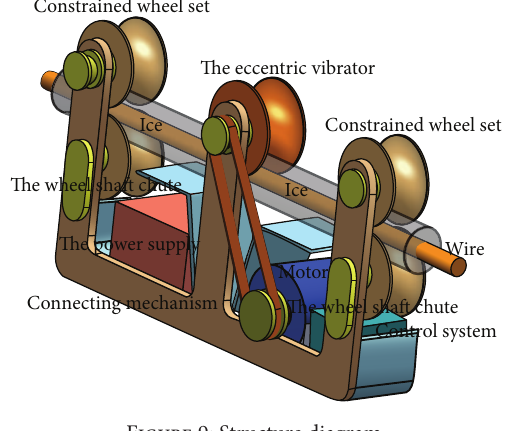
Figure 9: Structure